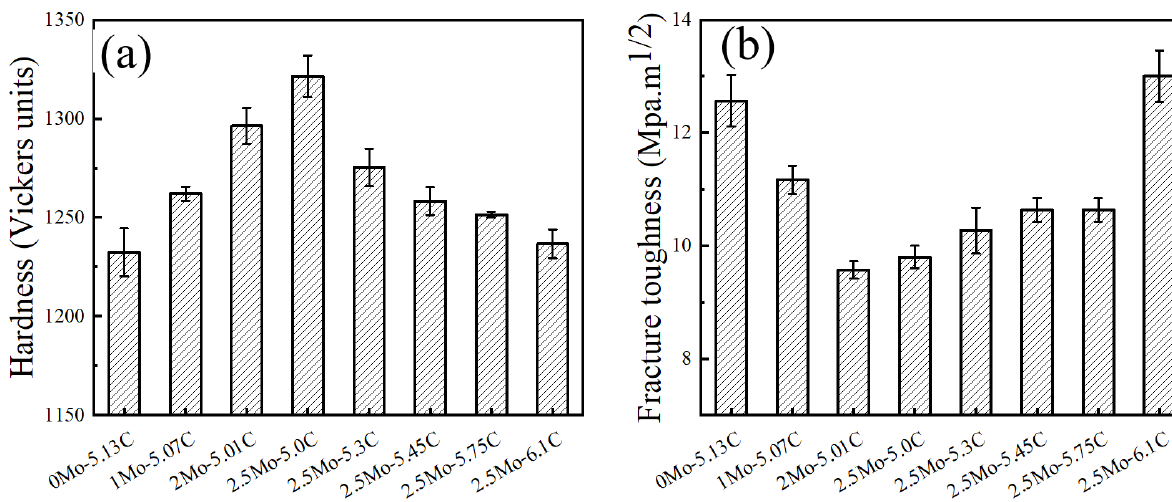
Figure 11. The hardness ( a ) and fracture toughness of different cemented carbides ( b ).